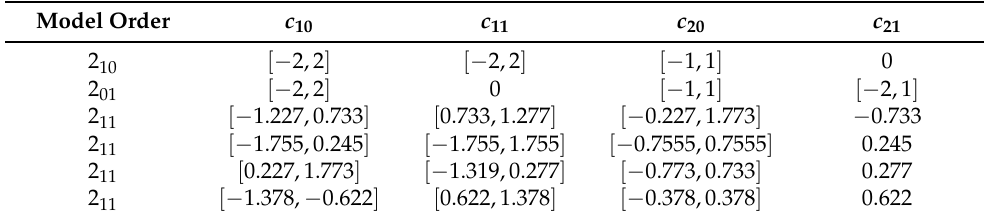
Table A1. Model coefficients, c XY corresponding to φ XY and/or θ XY . Coefficients are fixed or generated within the presented